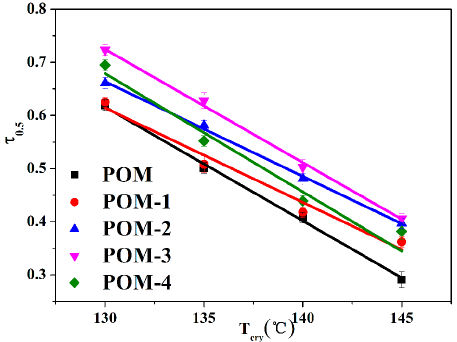
Figure 7. Plots of ln( − ln(1 − X t )) as a function of ln( t ) for POM/Ag nanocomposites: ( a ) POM, ( b )